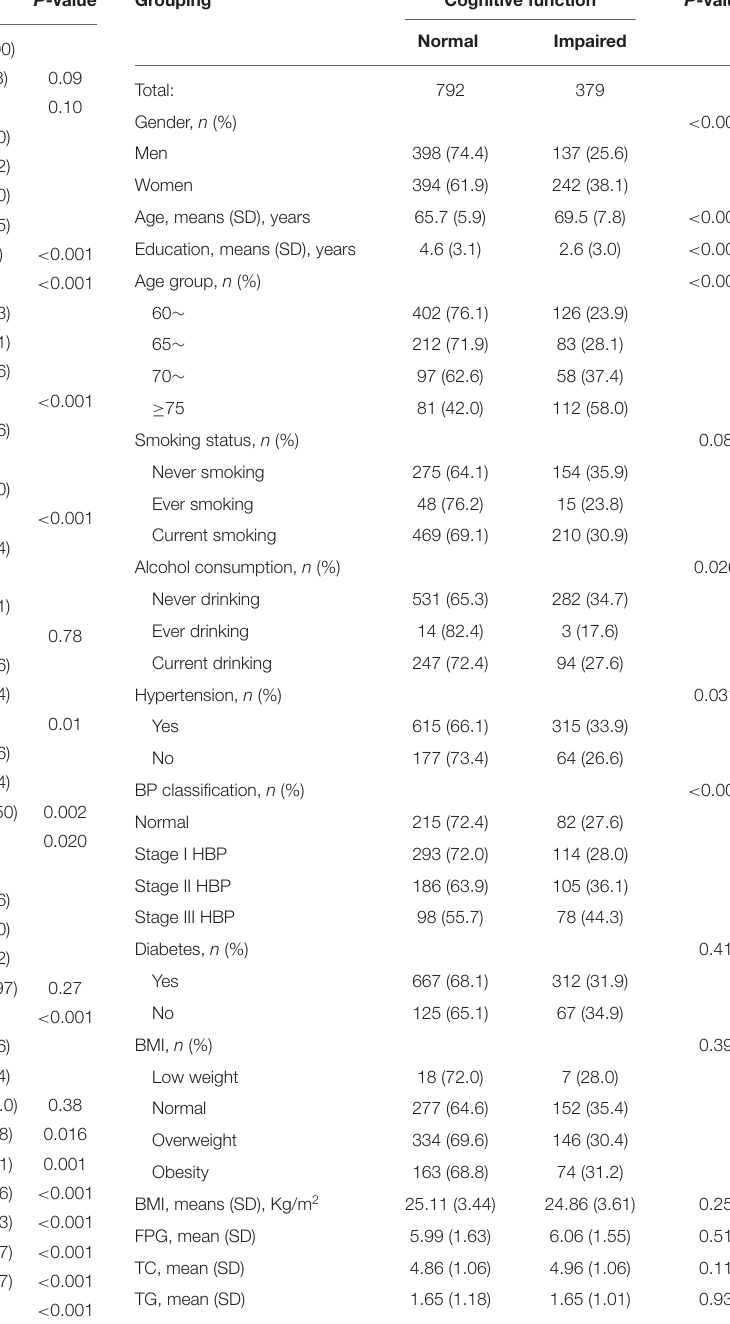
TABLE 1 | Characteristics of participants in this study. TABLE 2 | Univariate analysis of risk factors for cognitive impairment.